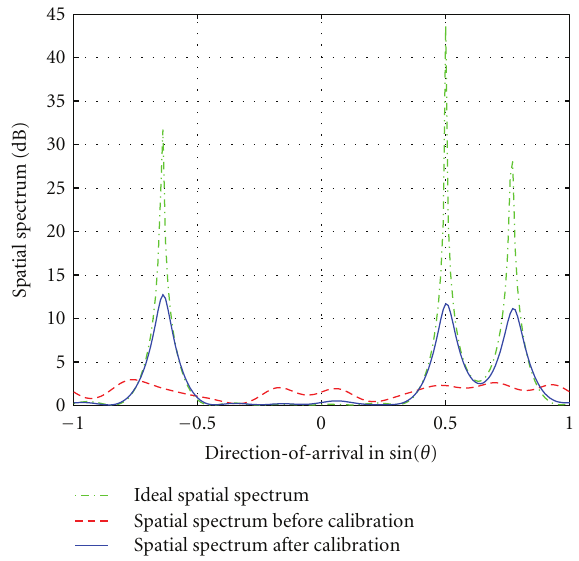
Figure 4: MUSIC spatial spectra obtained before and after joint gain/phase and mutual coupling calibration.